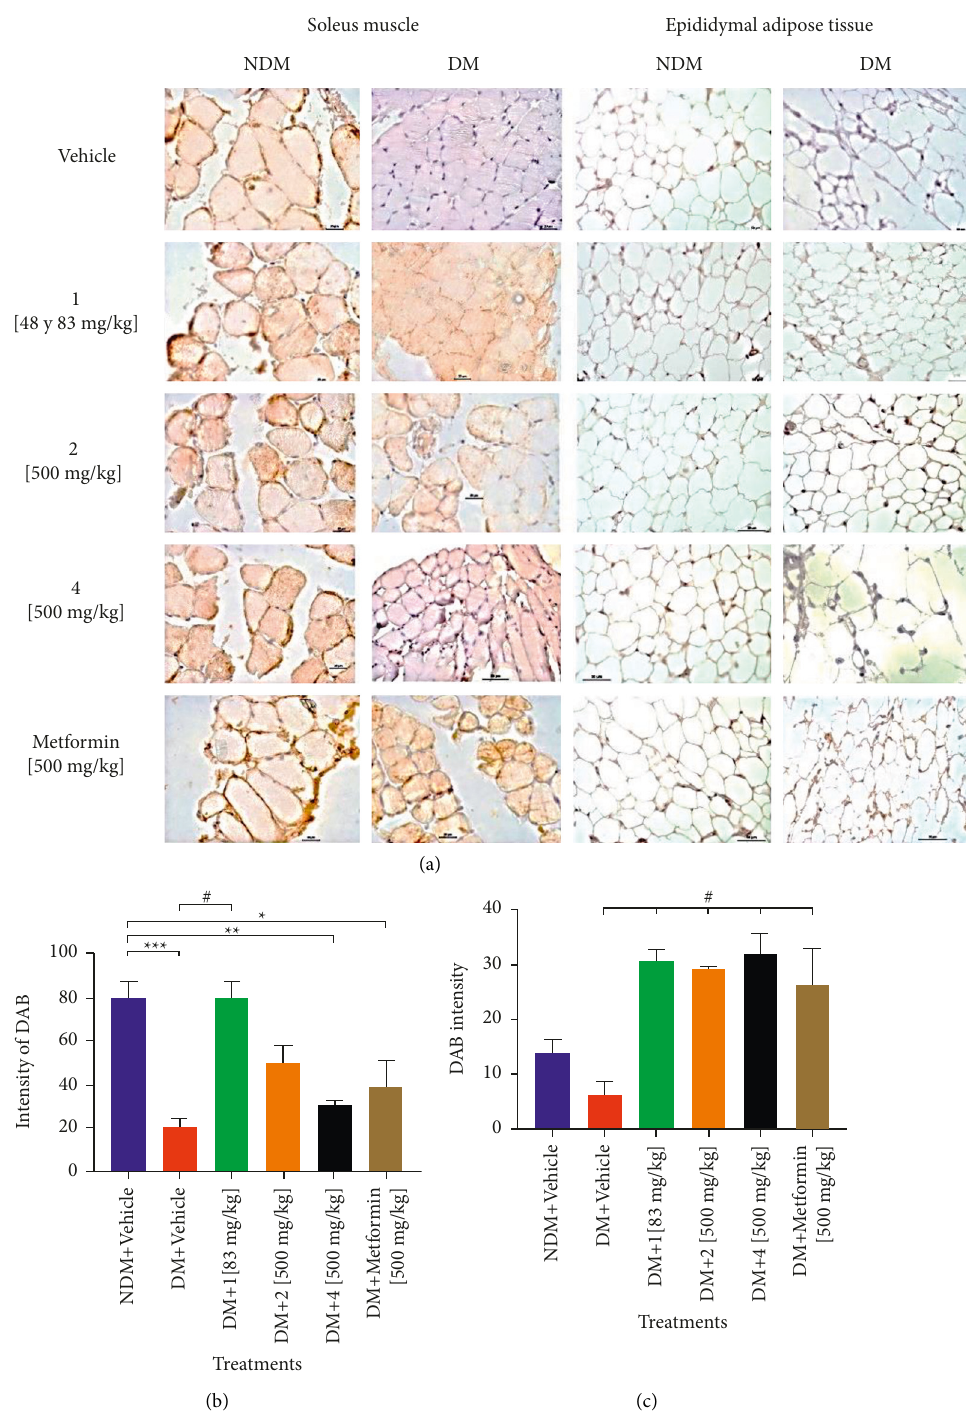
Figure 5: Immunohistochemistry of Glut4 in soleus muscle and epididymal adipose tissue. (a) Immunohistochemistry of SM and EATof nondiabetic (NDM) and diabetic (DM) CD1 mice treated with the vehicle saline 0.9% with Tween 20 0.1%, metformin, 1, 2, and 4; scale (cid:31) 40x; and bar 20 μ m. (b) Diaminobenzidine (DAB) intensity as an expression of the presence of Glut4 in PM of SM. (c) DAB intensity as an (cid:31) expression of the presence of Glut4 in PM of EAT. The DAB intensity was calculated with the “Fiji” version of ImageJ software. show significance at p 0 . 05, p 0 . 01, and p 0 . 001, respectively, versus NDM+ vehicle; # shows significance at p DM+vehicle. The error bars represent the standard error mean of measurements for n (cid:31) ∗∗ ∗ ≤ ≤ ≤